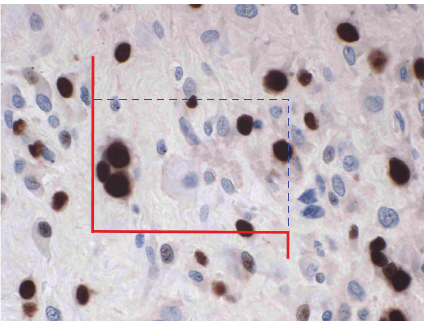
Figure 1: Field of vision showing an osteosarcoma stained immunohistochemically by MIB-1 to demonstrate cells in prolif- eration cycle (brown nuclear stain). A counting frame has been superimposed onto the histologic section for estimation of the rate and index of neoplastic proliferation. Using an unbiased two- dimensional counting rule, nuclei in focus inside the frame or on the hatched, blue edges are counted, as long as they do not intersect with the fully drawn, red exclusion edges of the frame or their extensions. In this example, 6 nuclei in cycle (brown) and 10 “resting” nuclei (blue) are counted (original magnification: